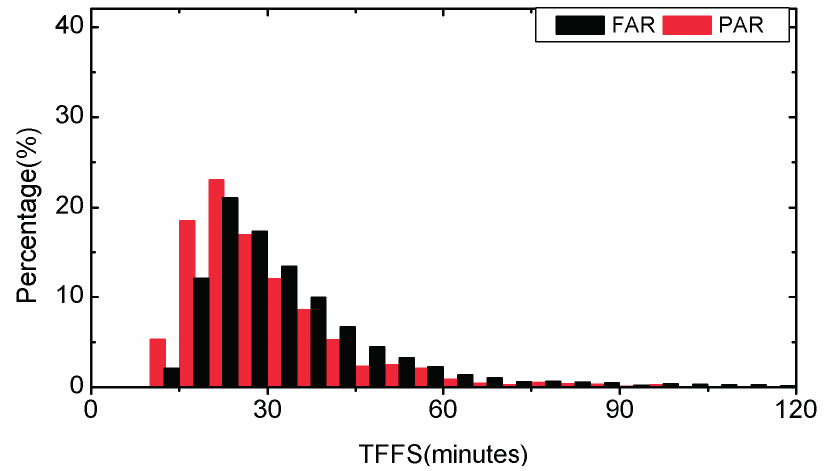
Figure 4. Distribution of TTFF of kinematic PPP by employing FAR and PAR,